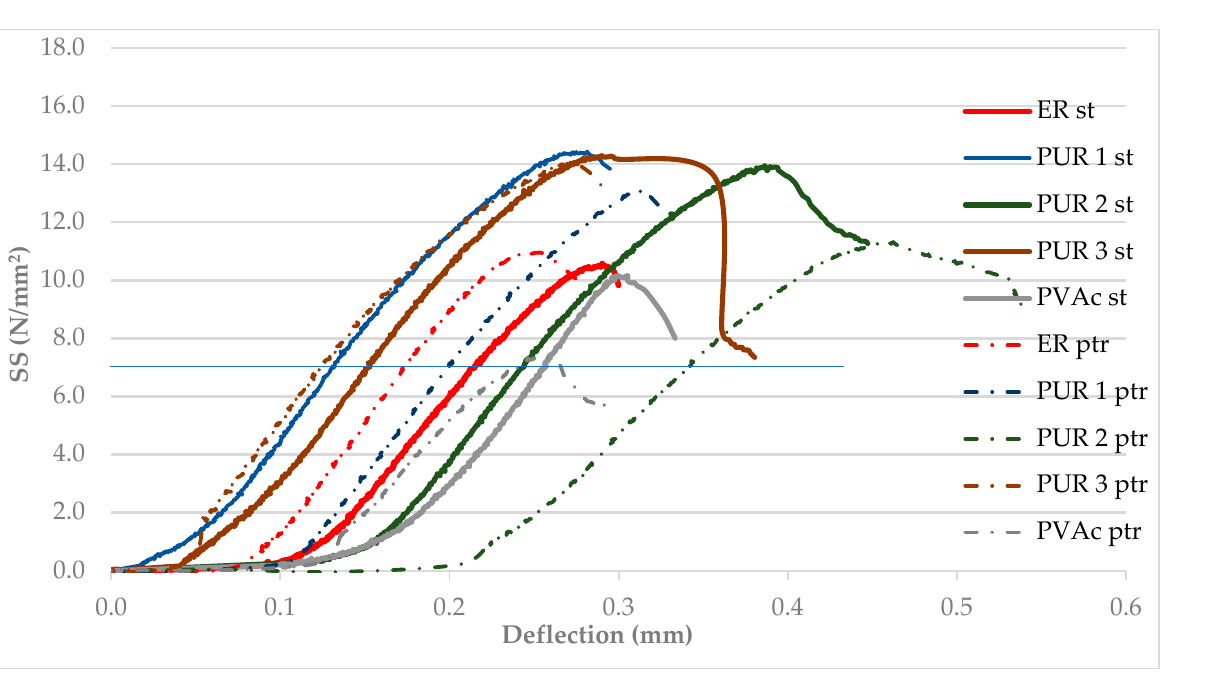
Figure 4. Strain—deflection curve for the reference and treated samples (mark st—standard conditioned samples, mark ptr—climatically pre-treated samples).